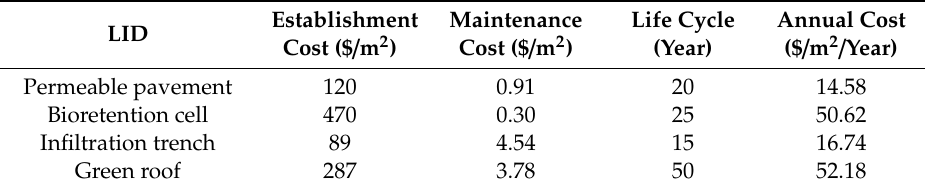
Table 4. Establishment cost, maintenance cost, and life cycle of LIDs.